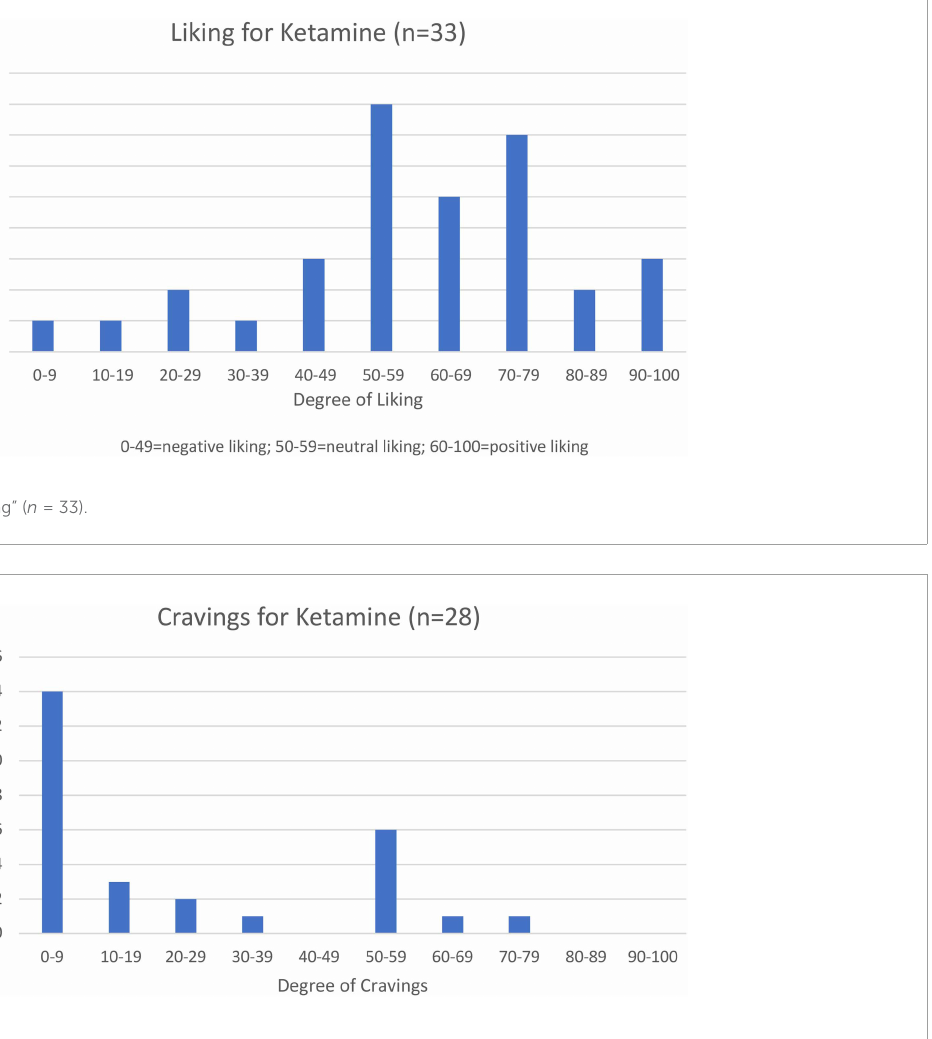
FIGURE2 Participant ratings of “drug craving” ( n =